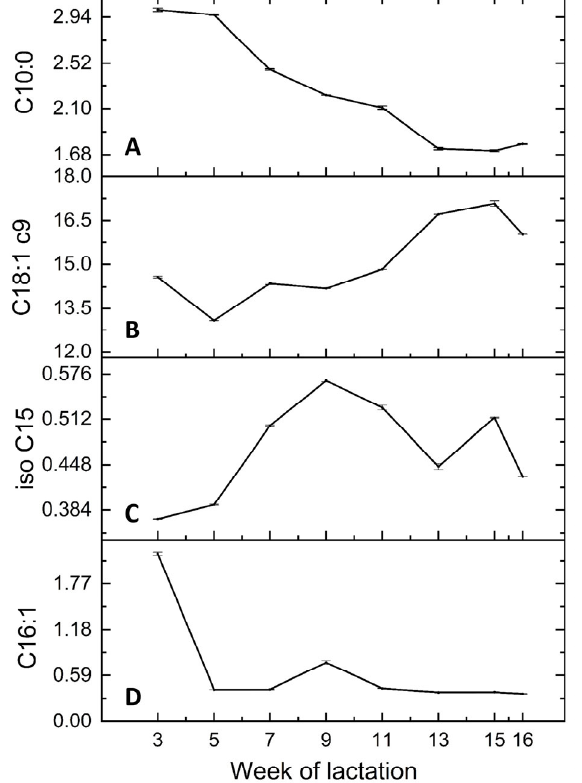
Figure 2. Variation patterns of representative fatty acids in deer milk (g fatty acid/100 g) over the lactation: ( A ) C10:0; ( B ) C18:1 c9; ( C ) iso C15; ( D ) C16:1.